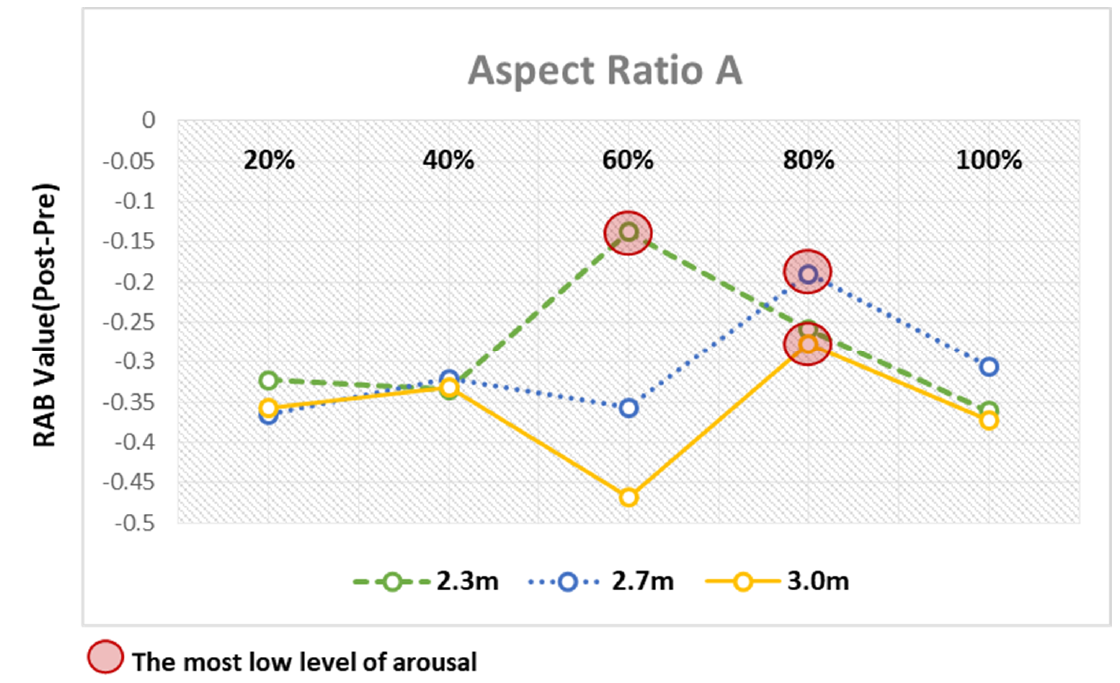
Figure 13. Analysis of arousal levels based on aspect ratio A.